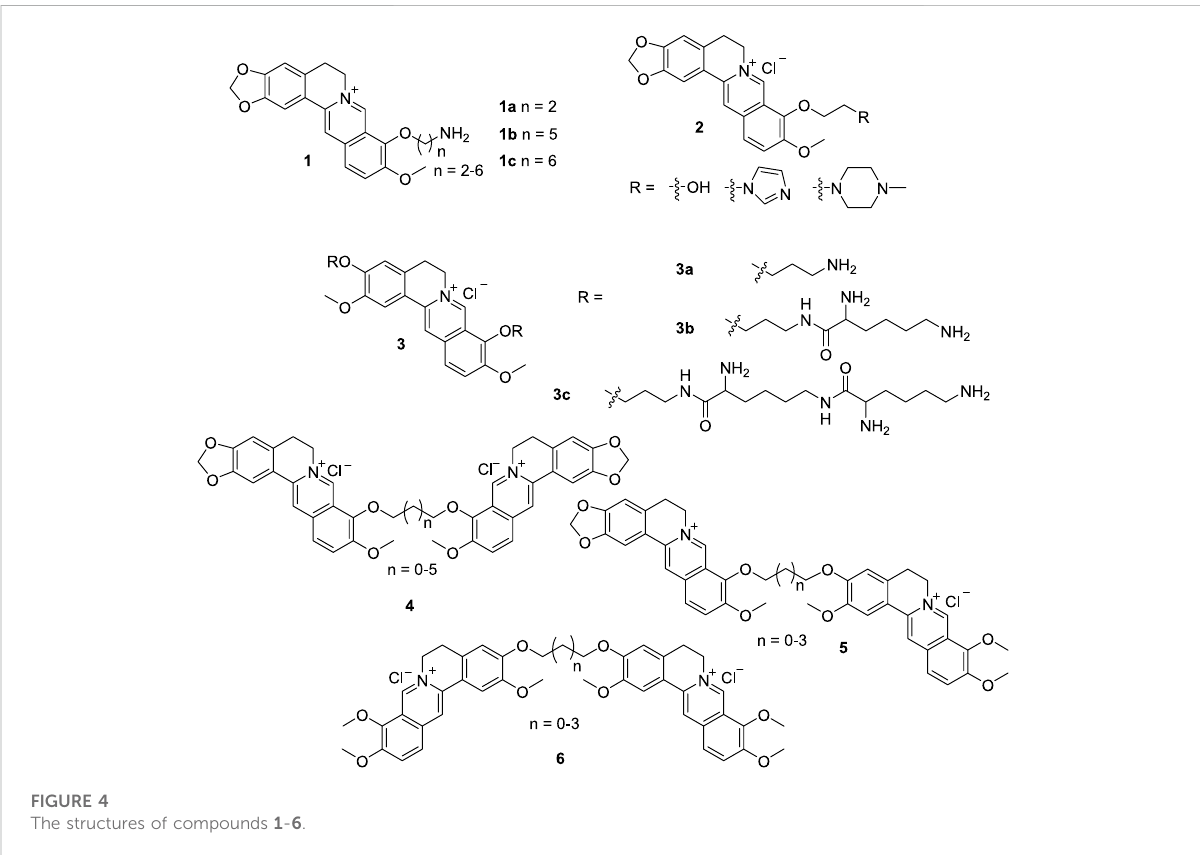
FIGURE 4 The structures of compounds 1 - 6